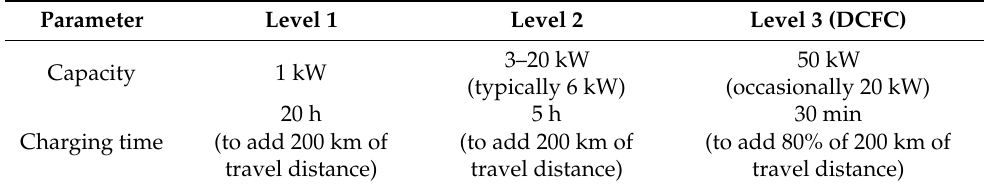
Table 3. Public charging stations